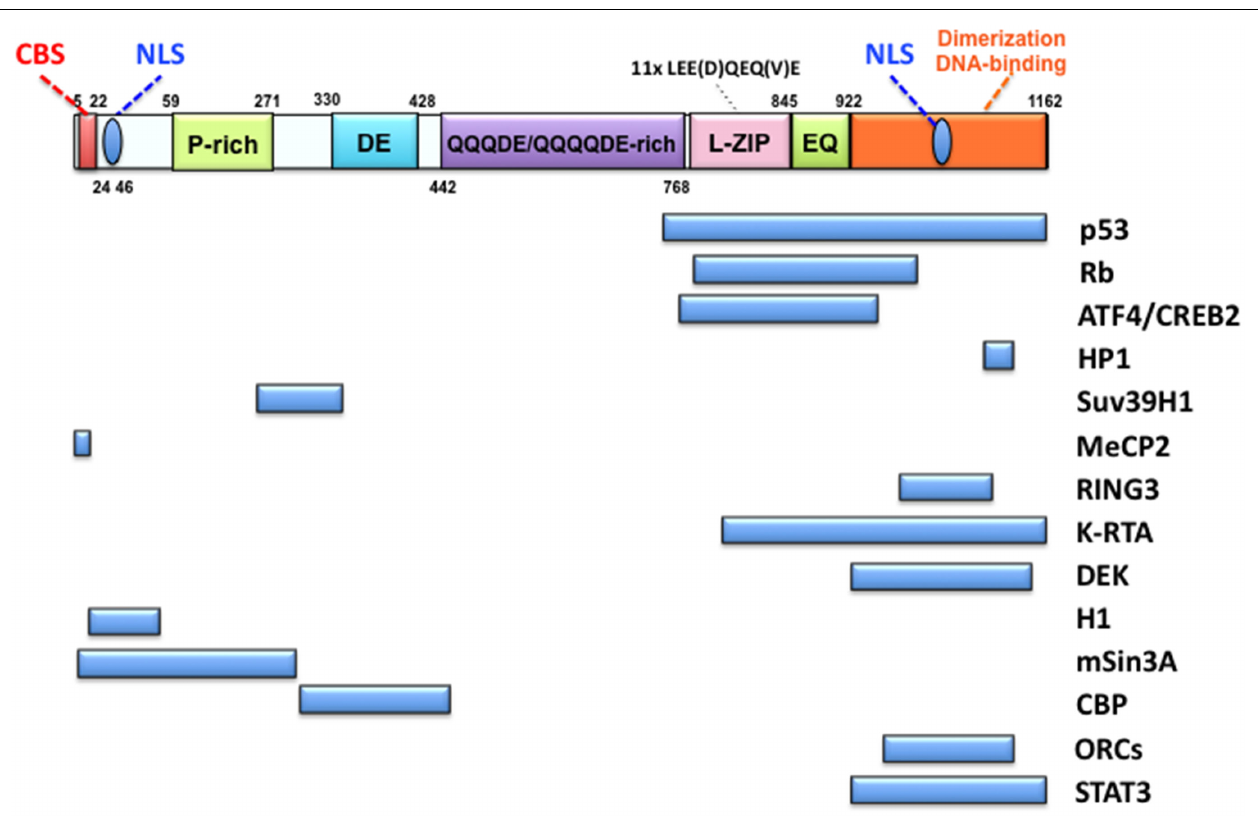
extremely aspartate (D)- and glutamate (E)-rich region (DE) and a glutamine (Q)-aspartate (D)-glutamate (E)-rich region (QQQDE/QQQQDE). LEE(D)QEQ(V)E looks like a leucine zipper but has not been recognized as a functional determinant.The C-terminal region has roles in both homo-dimerization and DNA binding to LBS.The main interacting proteins with LANA are listed below.The C-terminal region seems to be a region that interacts with many